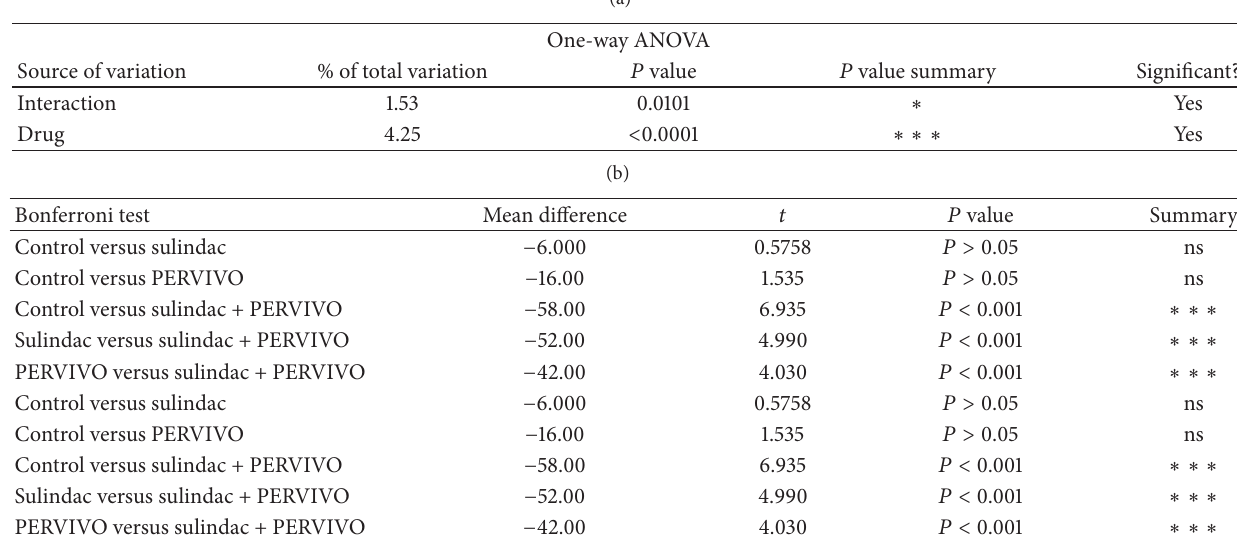
Table 5: Statistical analysis of the results presented in Figure